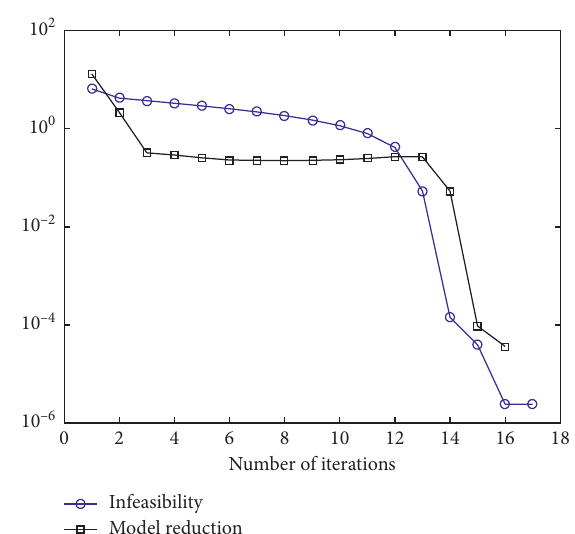
Figure 4: The termination conditions change with iterations for the 118-bus system.